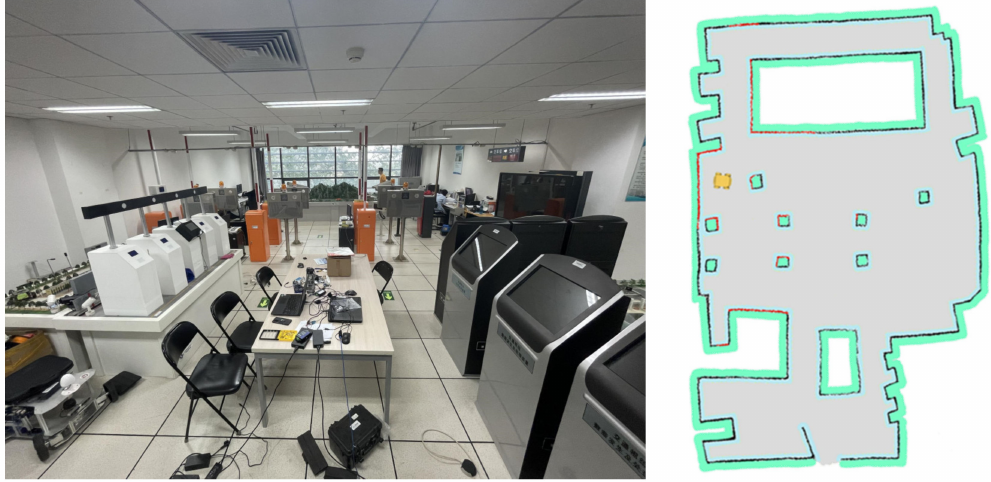
Figure 7. An initial map of a laboratory as an example built by